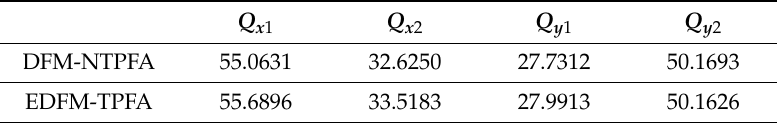
Total flux in x , y directions using discrete fracture-matrix–nonlinear two-point flux approximation (DFM-NTPFA) and embedded discrete fracture–matrix–two-point flux approximation (EDFM-TPFA) methods corresponding to the results of Figure